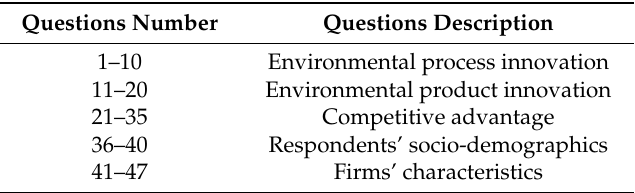
Table 1. Questionnaire structure.